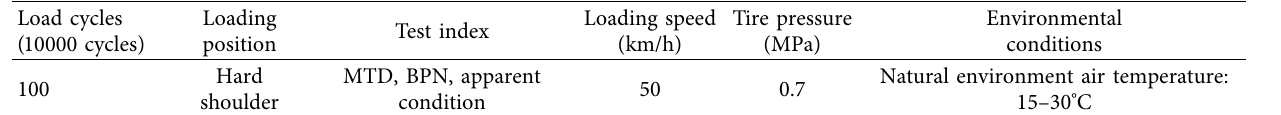
Figure 3: Loading equipment and test method. (a) PaveMLS 11. (b) Sand patch test. (c) BPN test. Table 5: Accelerated loading test